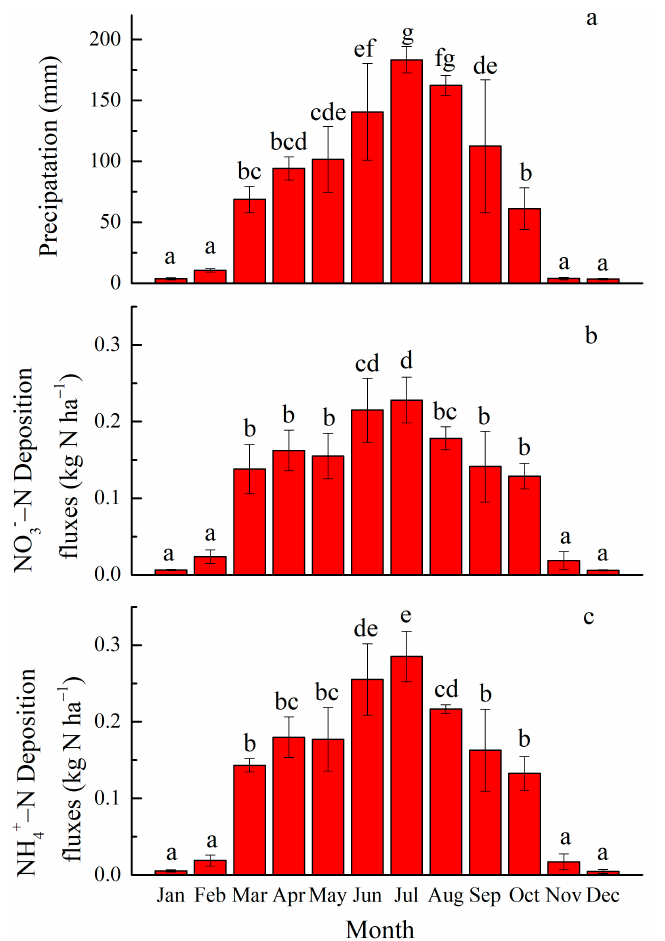
Figure 2. Variation of monthly precipitation amount ( a ), NO 3 − ( b ) and NH 4+ ( c ) deposition. Different letters above the error bar means that the difference reaches a significant level. Correspondingly, the same letters exists above the error bar that means the difference is insignificant.